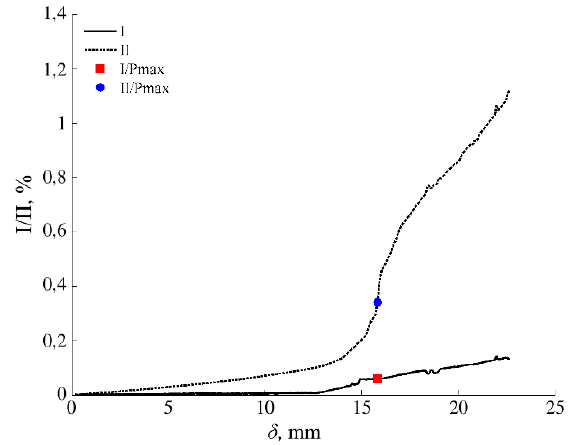
Figure 6. Normal (I) and transverse (II) crack tip opening displacements in relation to crack extension measured by DIC during an ENF test (specimen “144-1”).